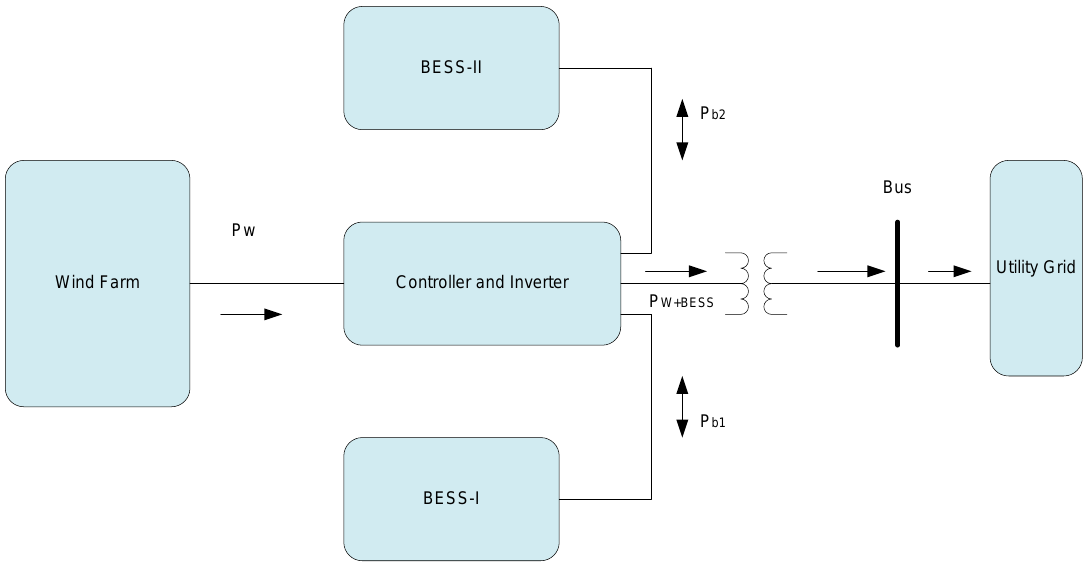
Figure 3. Schematic diagram of the BESS-associated WF.